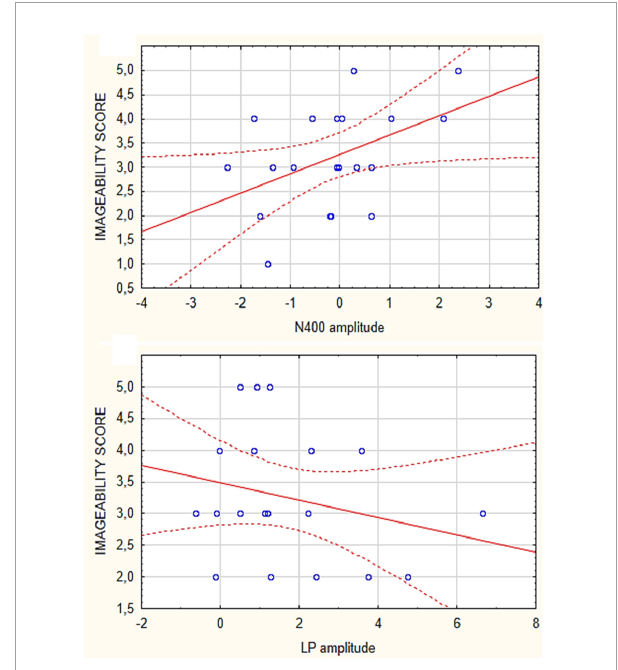
FIGURE6 Spearman Rho correlations between imageability scores attributed to the secondary need category (music listening, moving, social play) and the mean areas values of N400 (top) and LPP responses (bottom) recorded in the individual